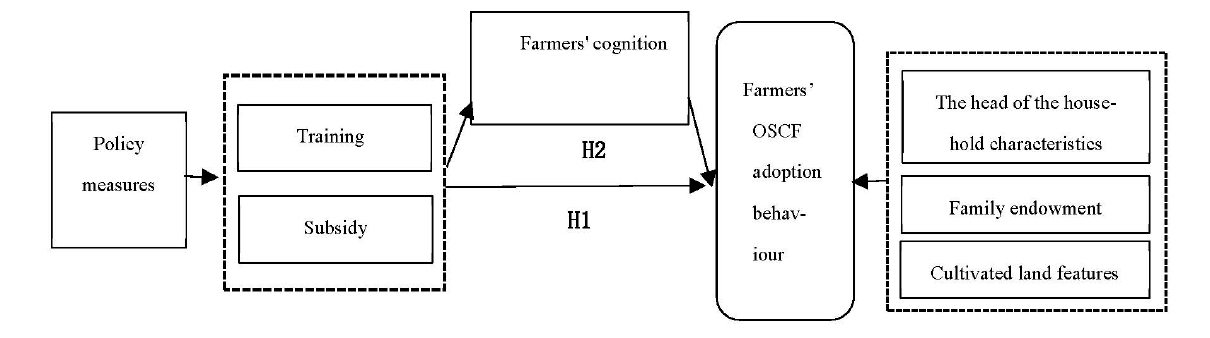
Figure 1. Theoretical Framework.